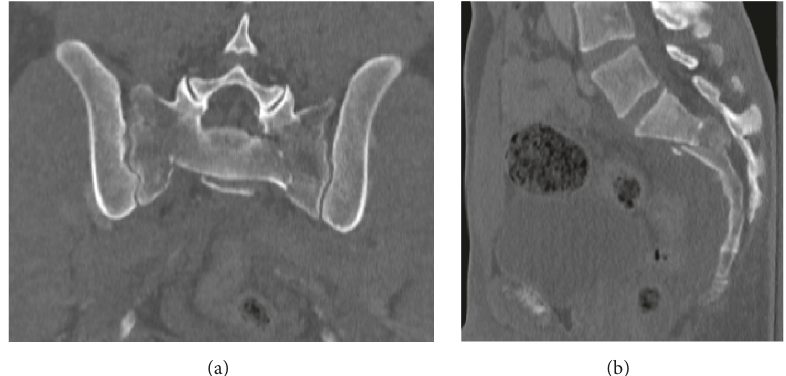
Figure 1: Coronal (a) and midsagittal (b) preoperative CT scan. Note the bilateral sacral fractures with horizontal S2 fracture with a 37-degree kyphotic deformity.